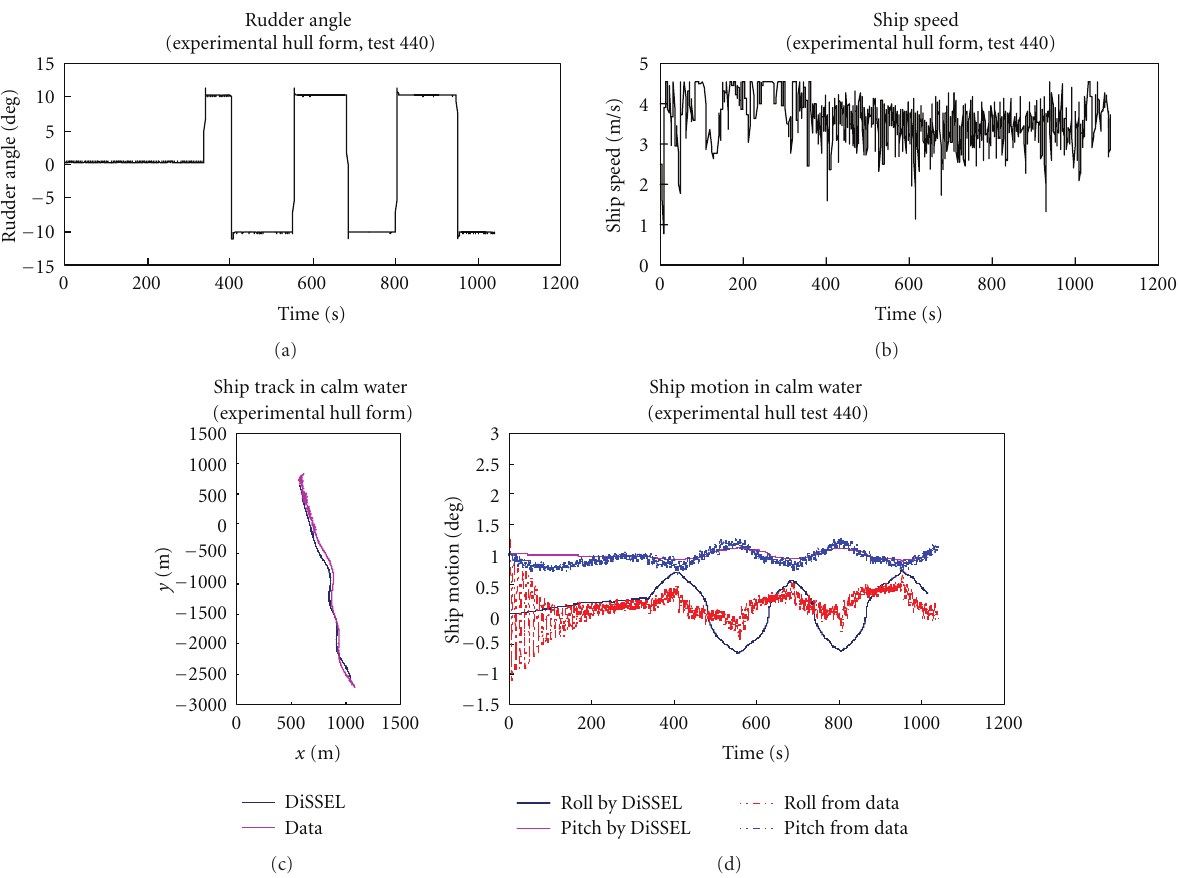
Figure 6: The data input for case 6 are shown in (a) and (b). (a) Rudder angle from data in test 440, (b) ship speed from data in test 440. The benchmarking simulations are shown in (c) and (d). (c) Comparison of ship track between simulation and experimental data in test 440. (d) Comparison of roll and pitch motion between simulation and experimental data in test440.